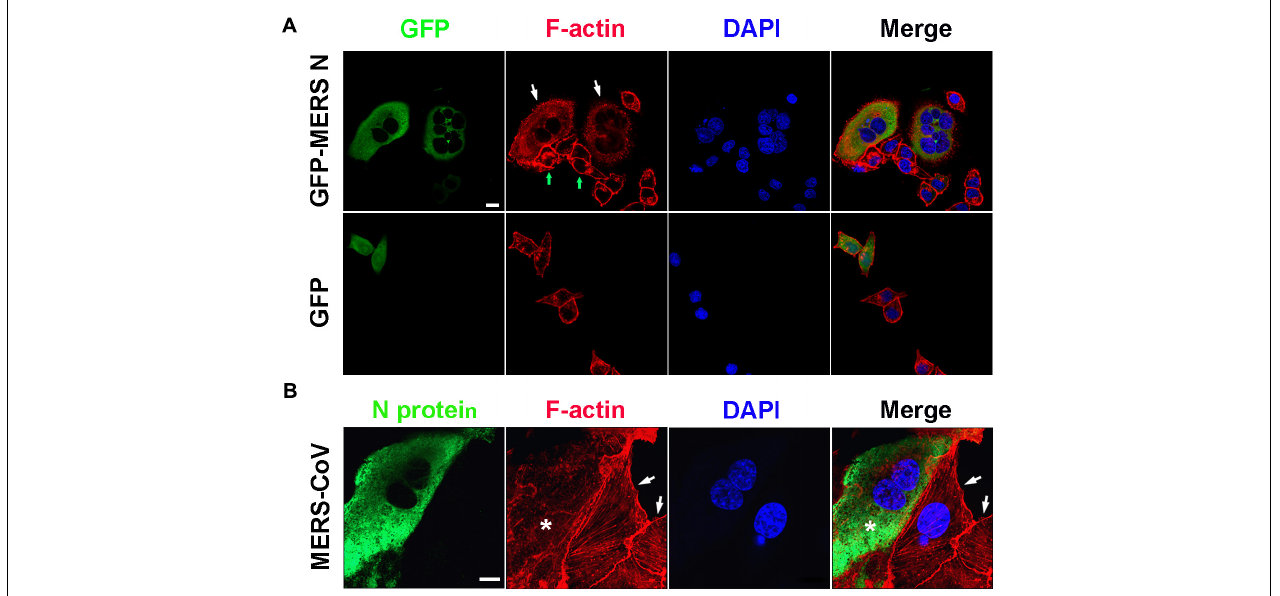
FIGURE 5 | Actin bundling is disturbed in cells expressing the MERS-CoV N protein or infected with MERS-CoV. (A) HeLa cells transfected with the indicated plasmids were fixed and stained for immunofluorescence. Arrow: cells expressing GFP-MERS-CoV N or GFP only. Scale bar, 10 µ m. (B) Vero E6 cells were infected with MERS-CoV and imaged by confocal microscopy. Green: MERS-CoV N stained with an anti-MERS-CoV N antibody and a FITC-labeled goat anti-mouse antibody. Red: F-actin stained with TRITC-phalloidin. Blue: nuclei stained with DAPI. Star: infected cell. Arrow: uninfected cell. Scale bar, 10 µ m.